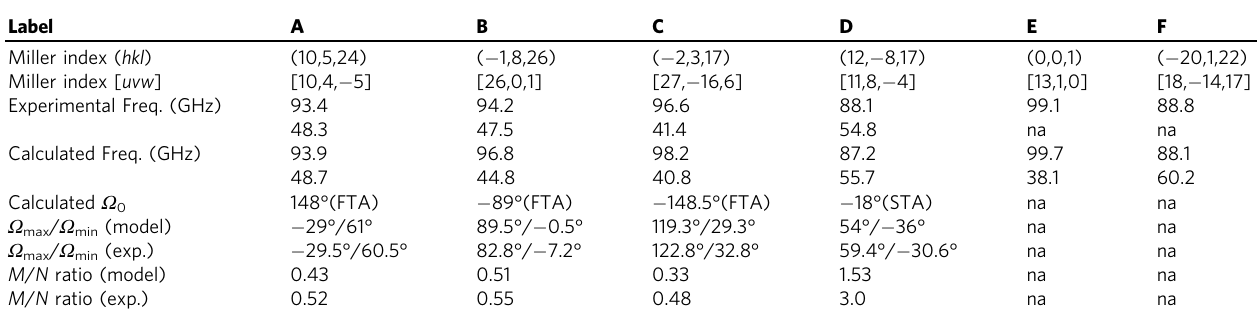
The calculated and measured frequencies for each crystallite compare closely.